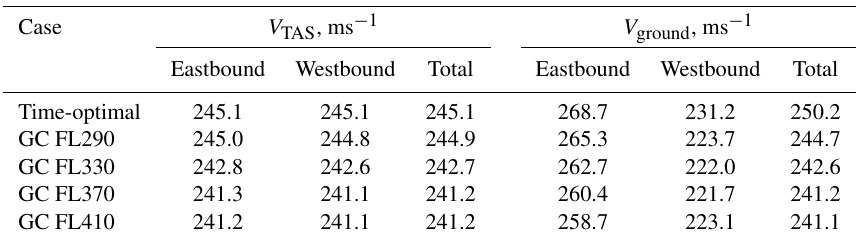
Figure 17. Obtained flight trajectories from 1-day AirTraf simulations corresponding to the time-optimal case including altitude changes in [ FL290, FL410 ] (a, b) and the great circle cases at FL290, FL330, FL370 and FL410 (c, d) . For each figure, the trajectories in the vertical cross section (top) and projection on the Earth (bottom). The 1-day flights comprise 52 eastbound (red lines) and 51 westbound flights (blue lines). Table 9. The mean value of V TAS and V ground for the time-optimal and great circle cases. The mean values were calculated using V TAS and V ground values at all waypoints. Eastbound: average of 52 eastbound flights; Westbound: average of 51 westbound flights; and Total: average of 103